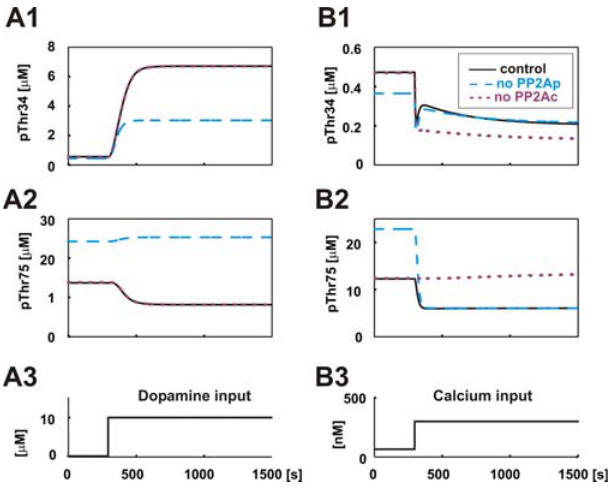
Figure 2. Model Response to Either D 1 Activation or Calcium Elevation Dopamine elevation at time 300 s (A3) leads to a nine times increase in phosphoThr34 within 2 min (A1, solid line), while phosphoThr75 is reduced to 60% of control (A2, solid line). This is quantitatively in accordance with experimental results. The PKA-dependent activation of PP2A is critical for this behavior; if left out of the model, phosphoThr75 increases instead of decreases (blue dashed line). Calcium-dependent activation of PP2A is not critical to simulate the correct response to D 1 activation (purple dotted line). Calcium elevation at time 300 s (B3) leads to a reduction in both Thr34 (B1, solid line) and Thr75 phosphorylation (B2, solid line). In contrast to the result in A1 and A2, this response requires calcium-dependent activation of PP2A; if left out of the model (purple dotted line), calcium causes an increase in Thr75 phosphor- ylation. DOI: